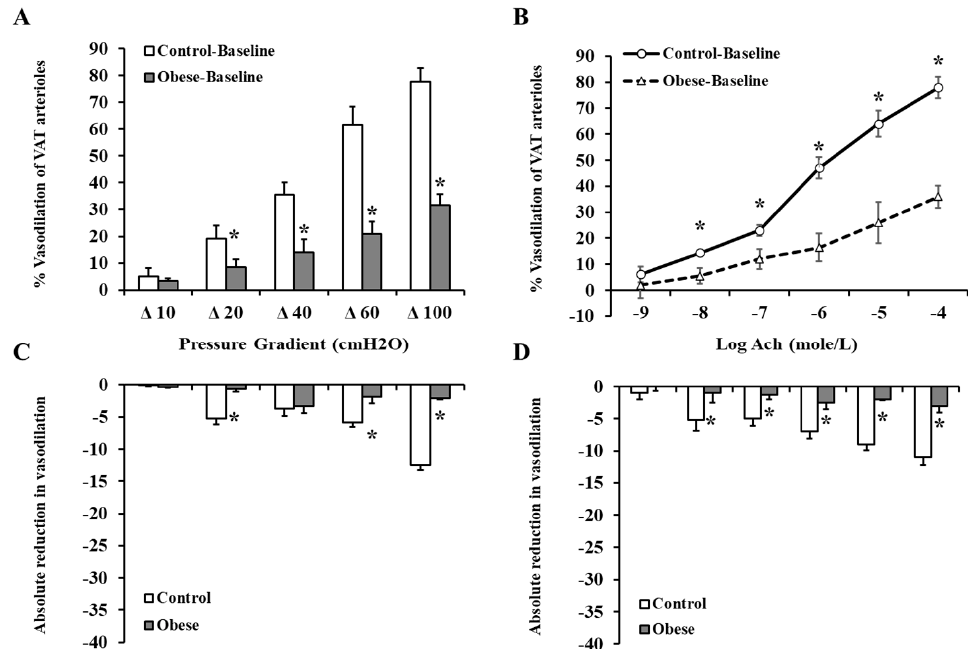
Figure 4. FID and AChID in VAT isolated resistance arterioles. FID measurements in VAT arterioles isolated from obese ( n = 40) and non-obese ( n = 40) subjects corresponding to increasing intraluminal pressure gradients of 10–100 cmH 2 O ( A ). AchID measurements in VAT arterioles corresponding to increasing concentrations of Ach (10 − 9 to 10 − 4 M) ( B ). Absolute reduction in FID in response to eNOS inhibition via L-NAME (10 − 4 M) ( C ). Absolute reduction in AchID in response to eNOS inhibition via L-NAME ( D ). All measurements are presented as means ± standard error (SE). * ( p < 0.05) for comparing obese subjects with controls.